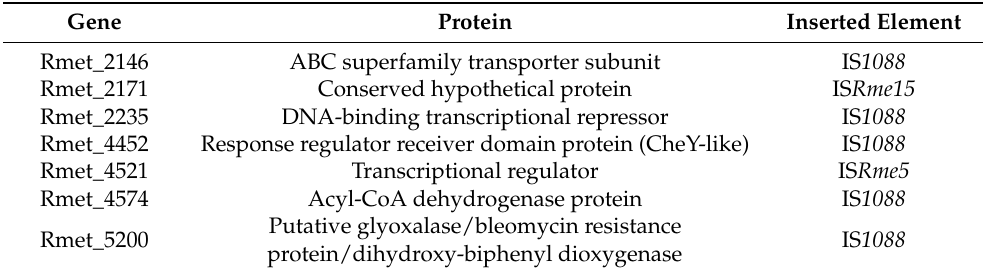
Table 4. Mutations identified in CH34 ZnR.